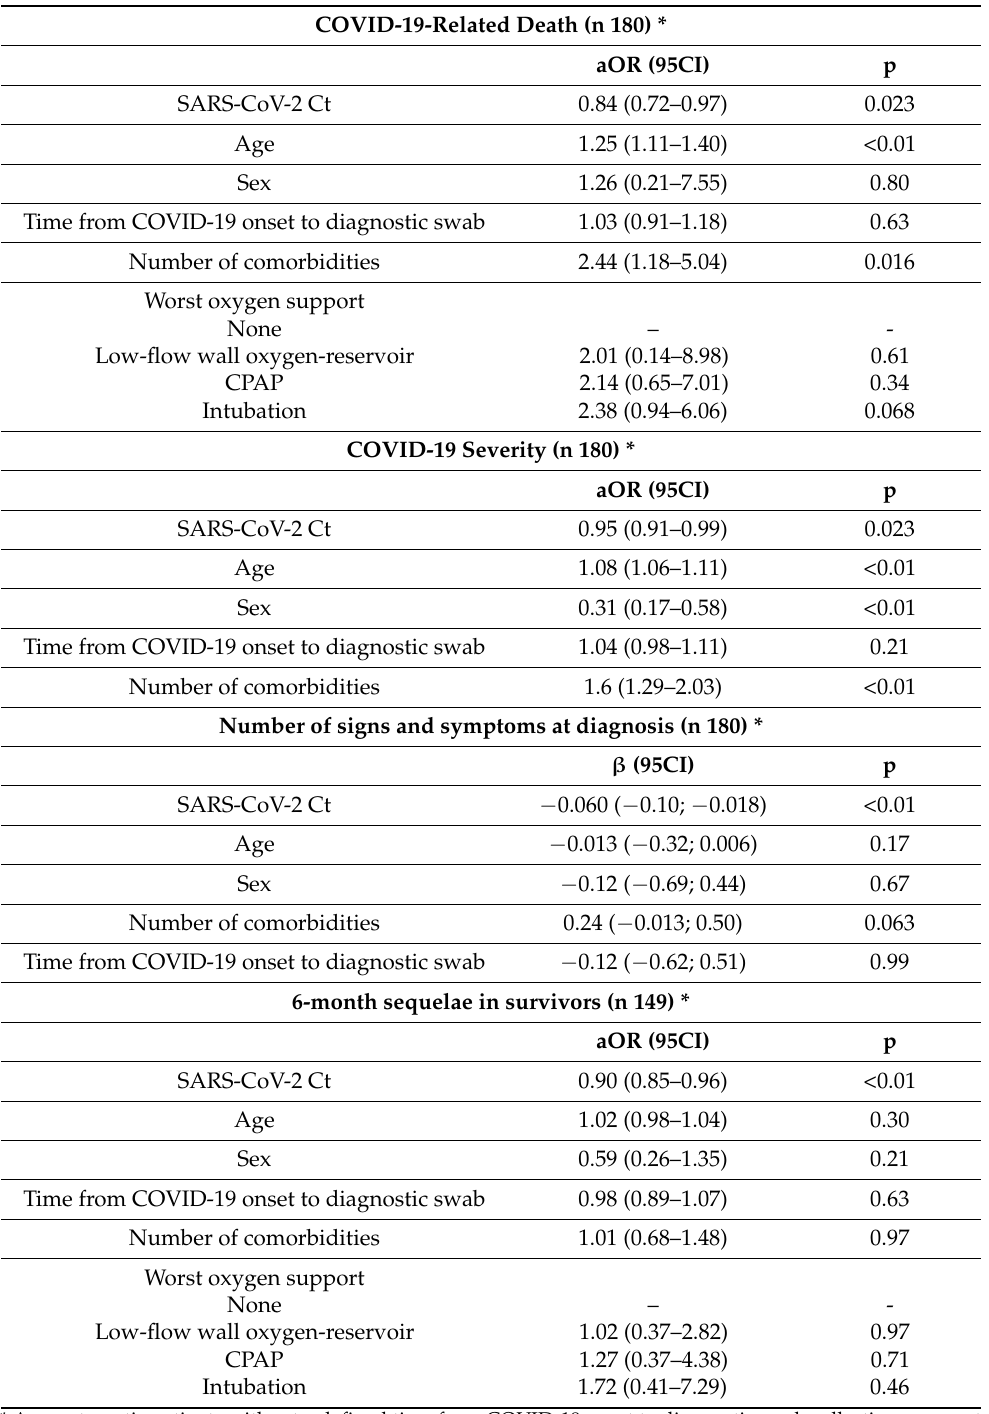
Table 3. Multivariate analysis for clinical outcomes, signs and symptoms at diagnosis, and long-term